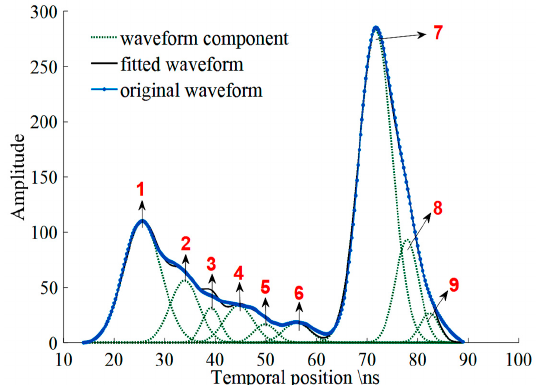
Figure 8. Results of the decomposition obtained with GHPD (the numbers in red represent the decomposition order of the waveform components).